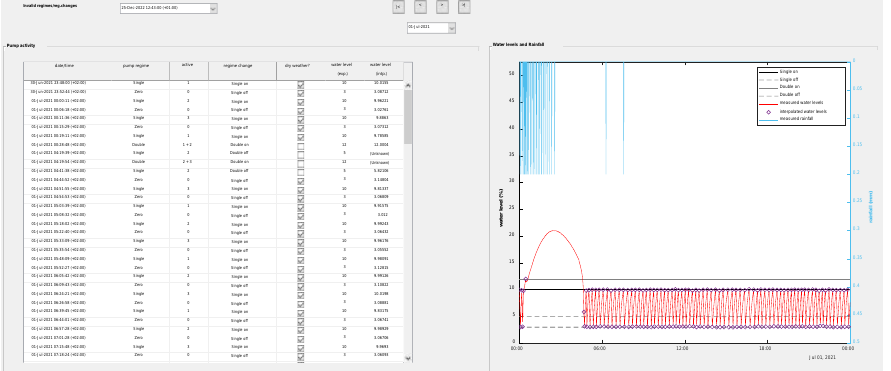
Figure A4. Example of data